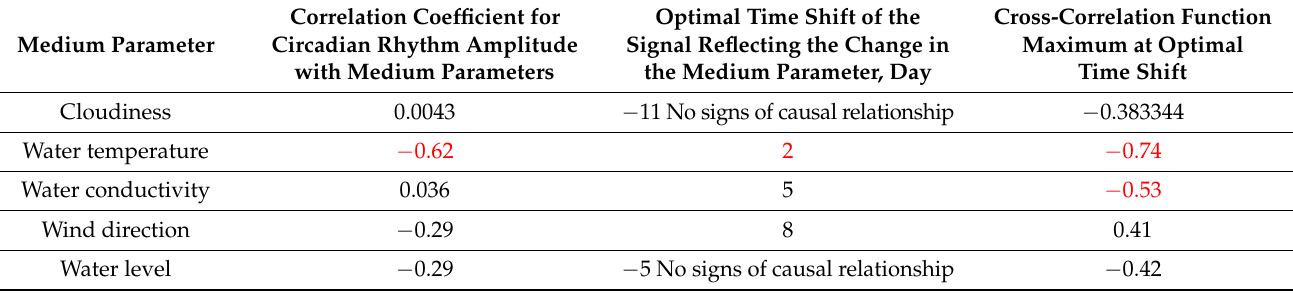
Figure 10. Parameters of the plankton circadian rhythm 3 August 2021 to 27 August 2021 against the background of habitat characteristics: wind direction, cloudiness, water temperature and water salinity of Baikal Lake (Bolshiye Koty mooring station). Weather data (wind direction, cloudiness) adapted with permission from Ref. [42] 2004–2022, Raspisaniye Pogodi Ltd. Water level adapted with permission from Ref. [43] 2015–2022, AllRivers.info. Water temperature and conductivity were taken from the DHC FOCL probe sensors. Table 2. Correlation analysis of the amplitude of E. baikalensis circadian rhythm with medium parameters. Red color shows the significant values of correlation coefficients, the level of significance of which is p ≤ 0.05, and which are related to the corresponding medium